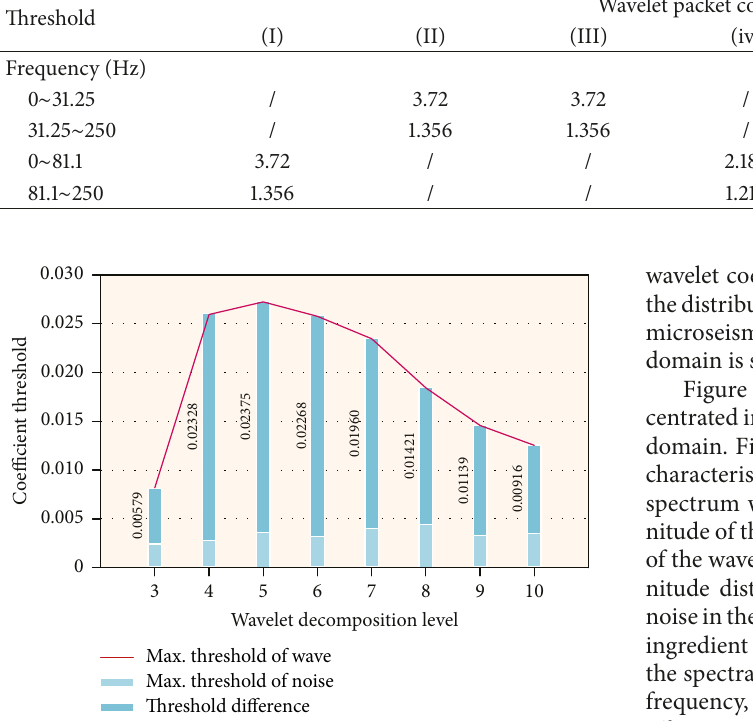
Figure 8: Changes in the magnitude of the maximum wavelet coefficient of the monitored microseismic wave and random noise with the decomposition level. The maximum coefficient magnitude of the monitored microseismic wave increases first from level 3 to level 5 and then decreases after level 5. The maximum coefficient magnitude of random noise continues to increase in a fluctuating manner until reaching level 8. The microseismic wave achieves the best wavelet packet decomposition at level